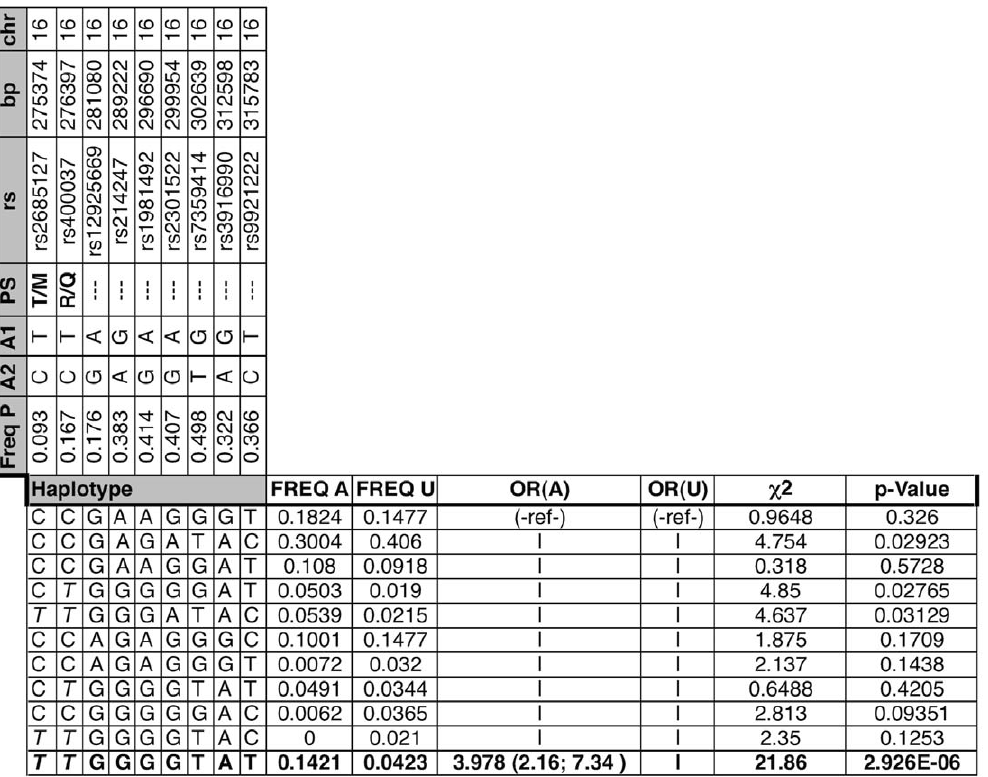
Figure 4. Haplotype Analysis for PDIA2 and AXIN1. ‘‘|’’ indicates haplotype grouped with one above it. Numbers in parenthesis represent 95% confidence interval. OR (A) and OR (U) abbreviate Odds Ratio Affected and Unaffected, respectively. Freq A, U, and P observed haplotype frequency Affected, Unaffected, and Population (control and experimental, this study); PS=Peptide Shift, italics bases within haplotype signify presence of peptide-shifting